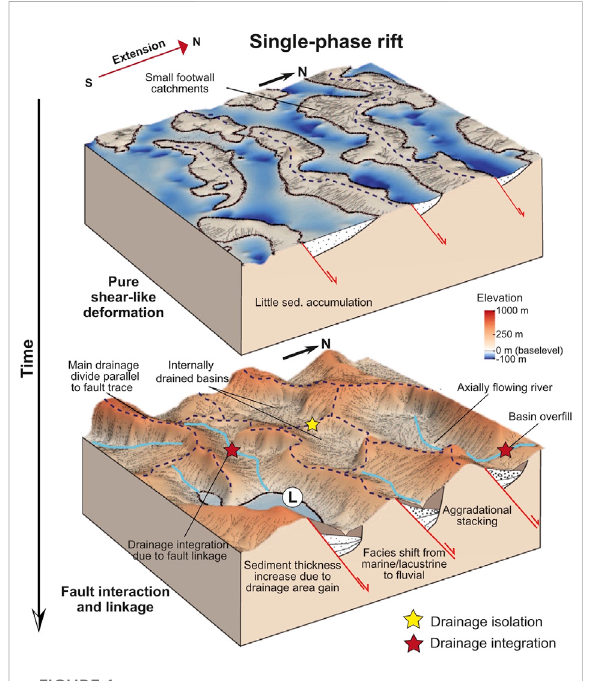
FIGURE 1 Block diagrams illustrating the evolution of topography, drainage network and stratigraphy for a numerical model of single-phase rifting. Modi fi ed after Pechlivanidou et al.,